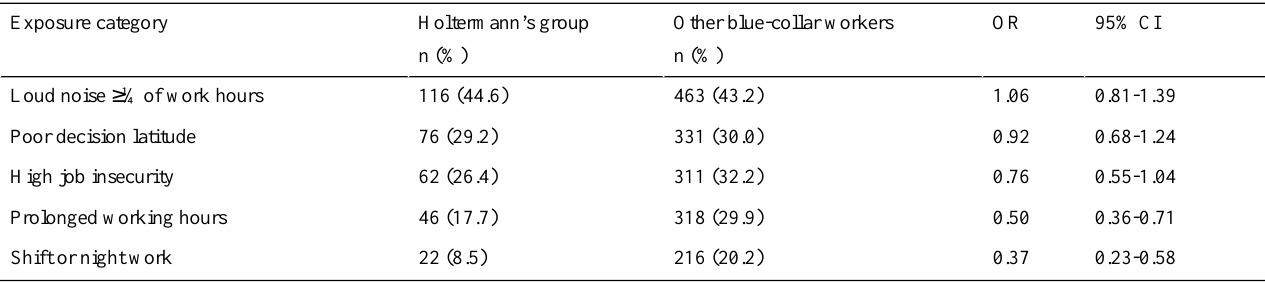
Table 4. Percentage of male workers exposed to loud noise, low decision latitude, high job insecurity, prolonged working hours, and shift or night work, according to DWECS 2000, by occupational category.